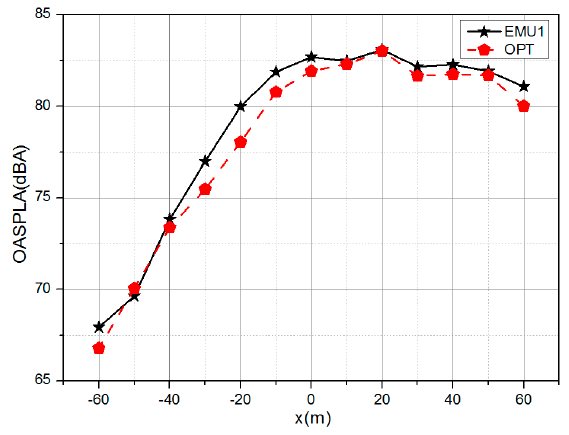
Figure 18. The Overall A ‐ weighted Sound Pressure Levels (OASPLAs) of all the probes before and after optimization.